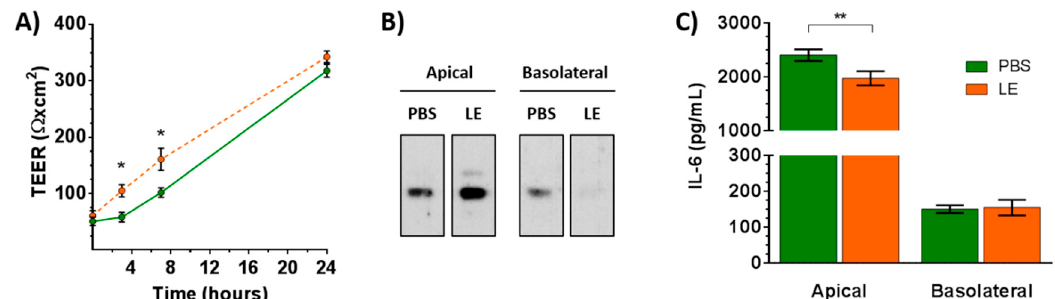
Figure 4. Effect of leek extract on the bronchial permeability to Ole e 1. ( A ) Time course of TEER values on day 2 ALI-cultured Calu-3 cells after treatment with leek extract (LE) compared to control cells (PBS). Data are the mean ± SD of triplicate determinations. * p < 0.05. ( B ) ALI-cultured Calu-3 cells were exposed to Ole e 1 (2.5 µg) on day 2 for 7 h after treatment with leek extract (LE, 5 µg/mL) for 24 h, and the presence of the allergen was determined in the medium using a rabbit polyclonal antibody. ( C ) ALI-cultured Calu-3 cells were treated with leek extract at 5 µg/mL (LE) for 24 h on day 2, and IL-6 levels in the medium were determined by sandwich ELISA. PBS, control cells. Data are the mean ± SD of triplicate determinations ** p < 0.01.